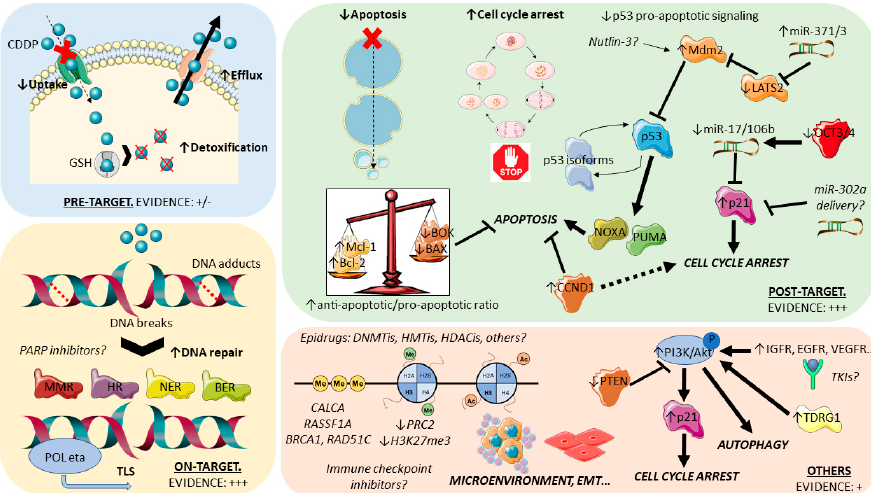
Figure 2. Pre-target, on-target, post-target, and o ff -target mechanisms involved in cisplatin resistance in (testicular) germ cell tumors. Most studies have focused on the on-target and post-target mechanisms (evidence: +++ ). Pre-target mechanisms are not thought to be major factors in the acquisition of cisplatin resistance in these tumors (evidence +/ − ). Other mechanisms are currently being explored, and related data is building up. A better understanding of these mechanisms underlies the development of specific e ff ective therapies of cisplatin-resistant patients (italics). Notice that epigenetic